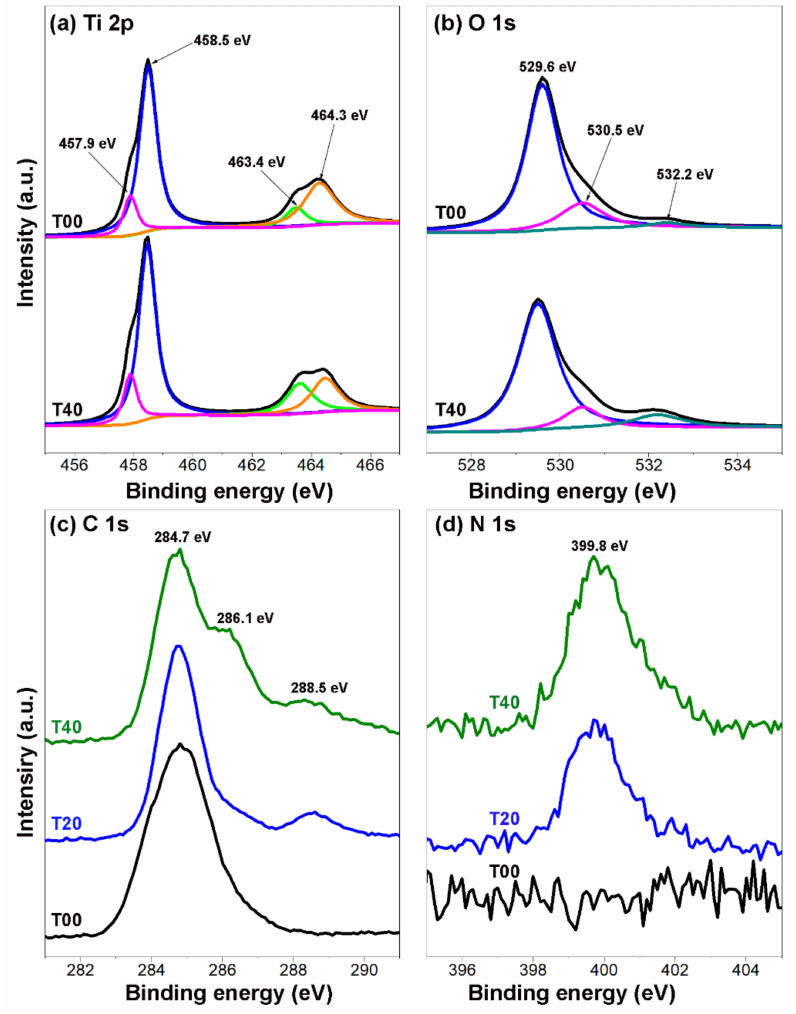
Figure 4. High-resolution XPS spectrum of different